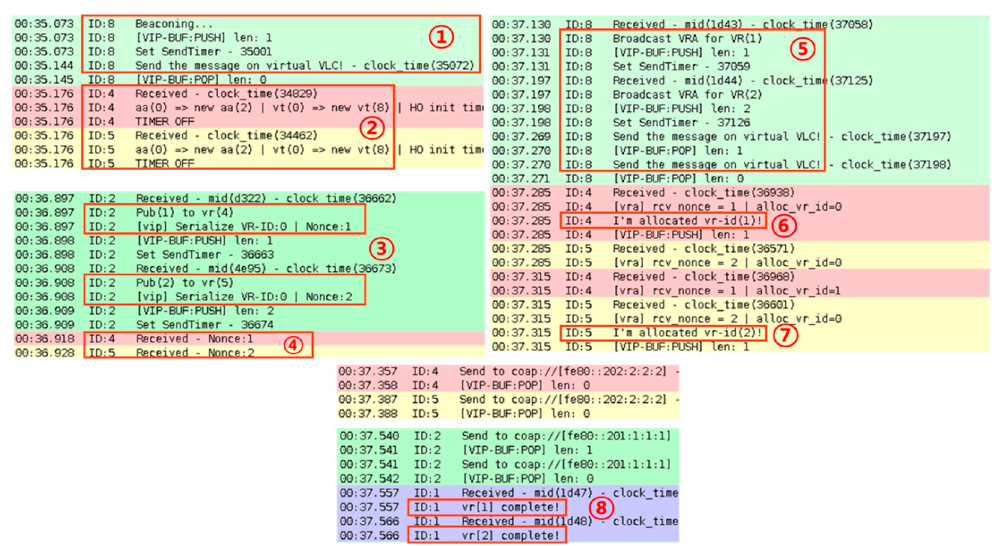
Figure 18. Packet analysis for VR discovery.